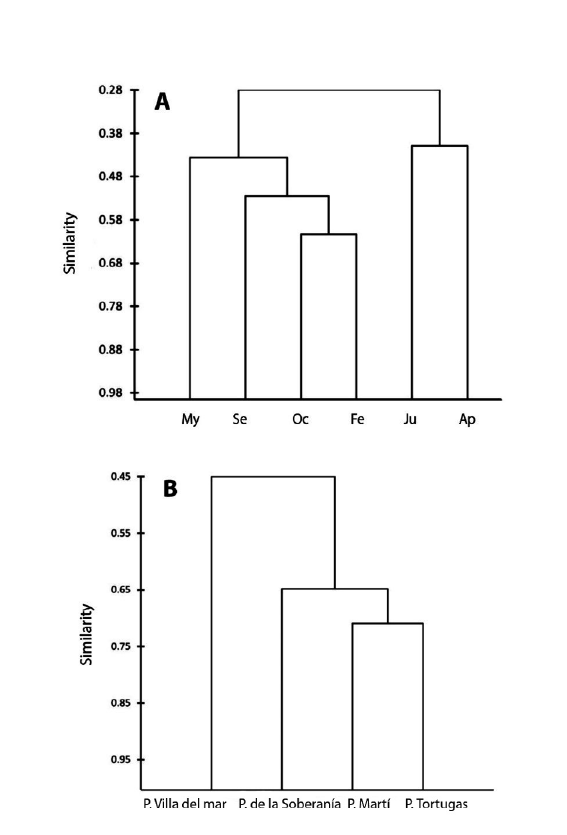
Figure 2. Cluster analysis. A , Grouping analysis of the sampling months; B , Grouping analysis of the sites from Parque Nacional Sistema Arrecifal Veracruzano (PNSAV), SW from Gulf of Mexico.